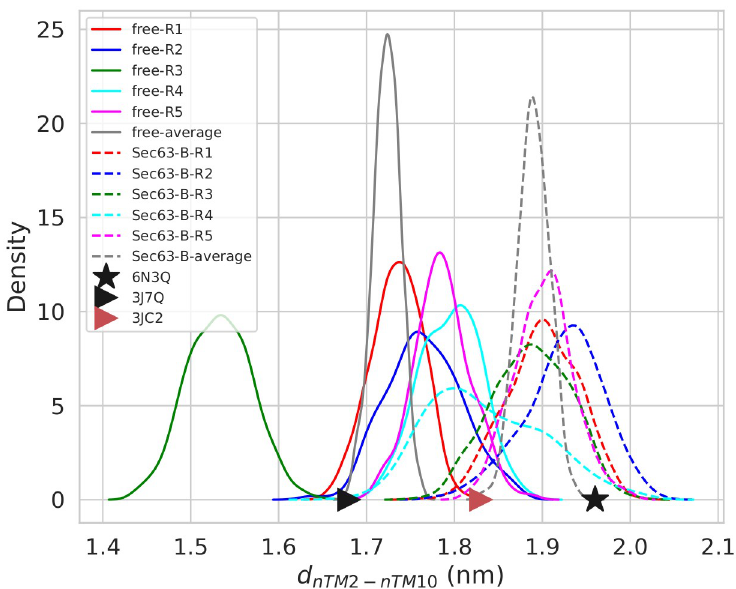
Fig 8. The probability distributions of d values obtained from the last 50 ns of five MD simulation nTM 2– nTM 10 replicas (Ri, i = replica number). Solid and dashed lines represent ‘free’ (free; without Sec63) and ‘Sec63-B’ (Sec63-bound) states, respectively. Black star, black triangular and red triangular symbols represent the values in the experimental cryo-EM structures of Sec complex, idle-state ribosome-Sec61 complex, and open-state ribosome-Sec61 complex,